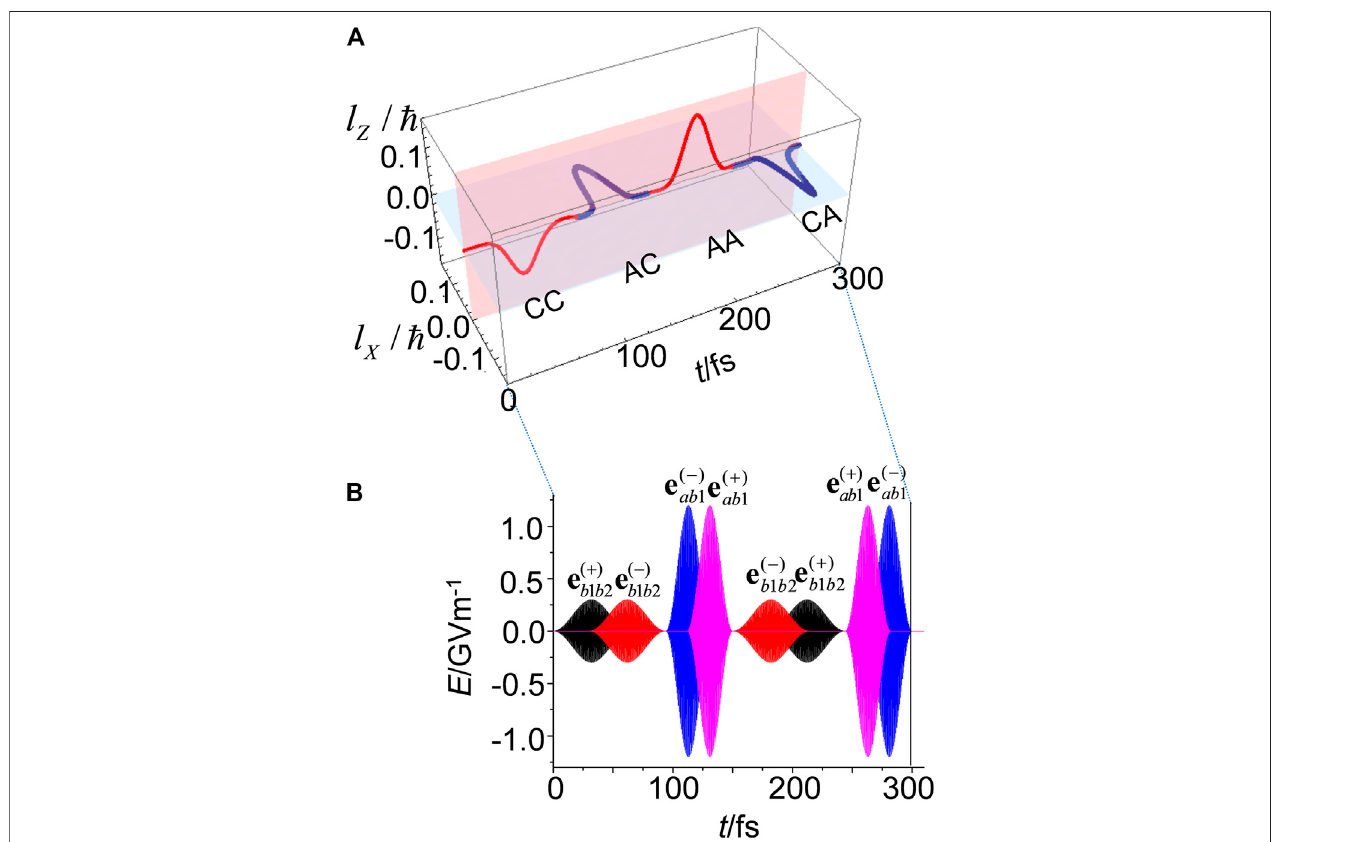
FIGURE 4 | (A) Sequential four-step quantum switching of π -electron rotations in ( P )-2,2 ’ -biphenol. (B) The sequential overlapped pump and dump laser pulses. Reprinted with permission from Ref. [40] Copyright (2012) American Chemical Society.